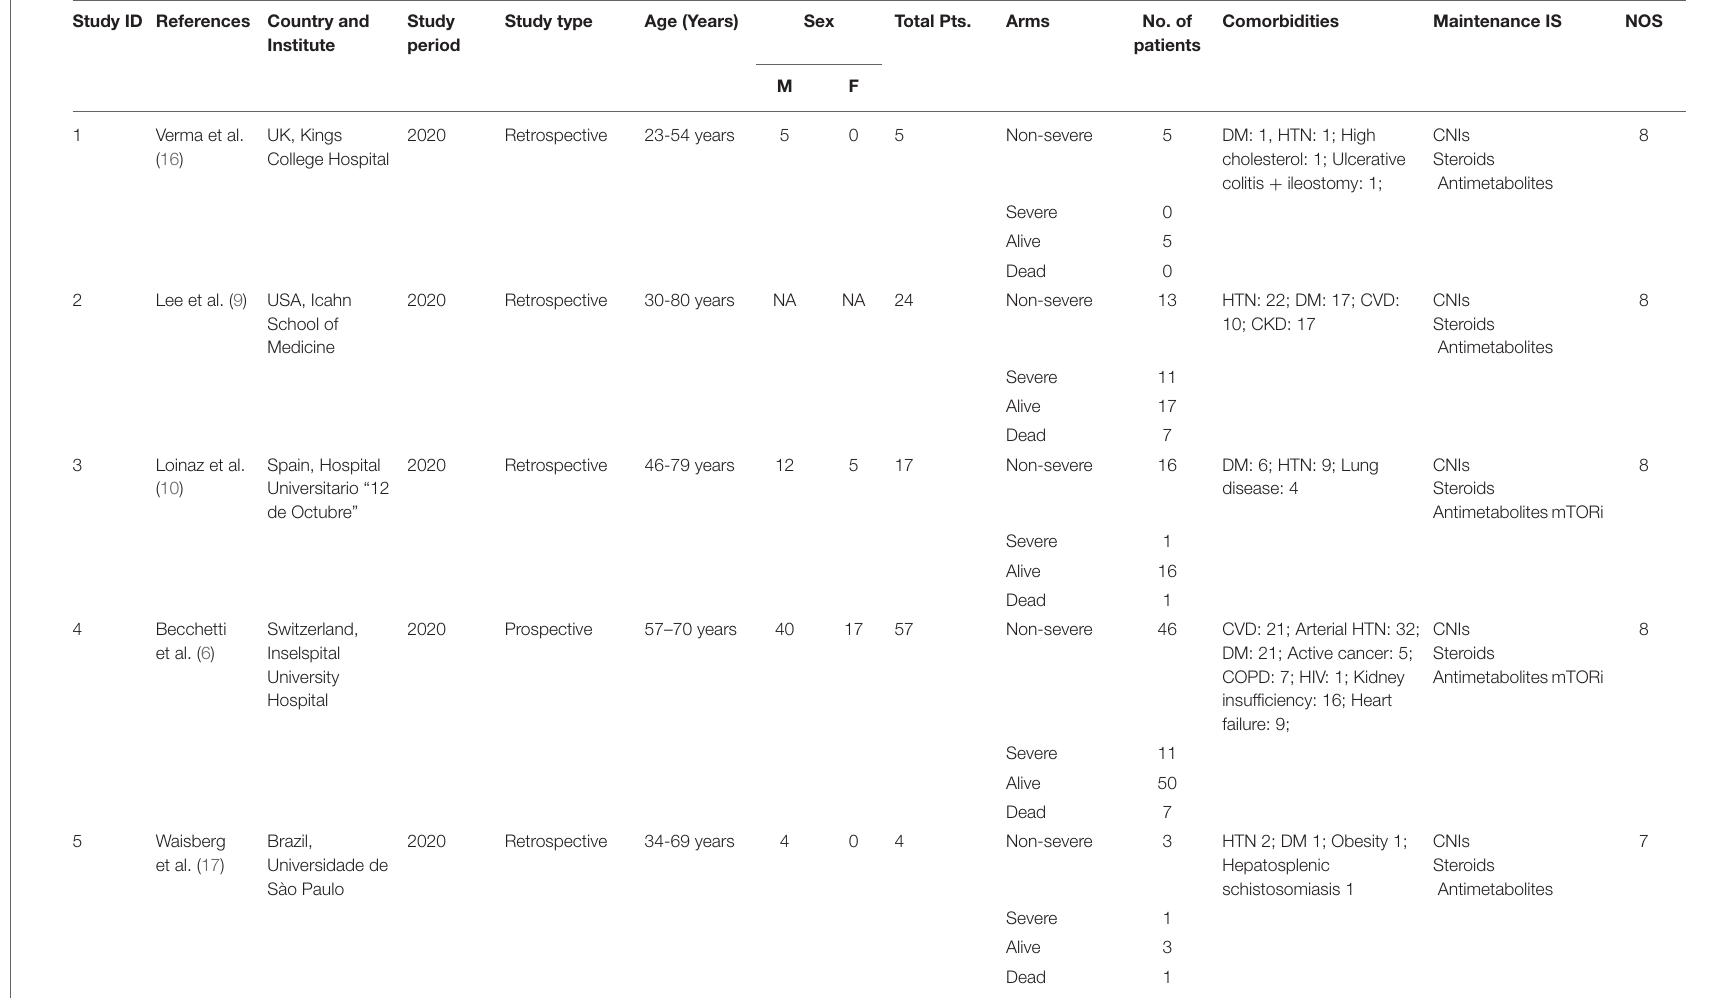
TABLE 1 | Characteristics of the included